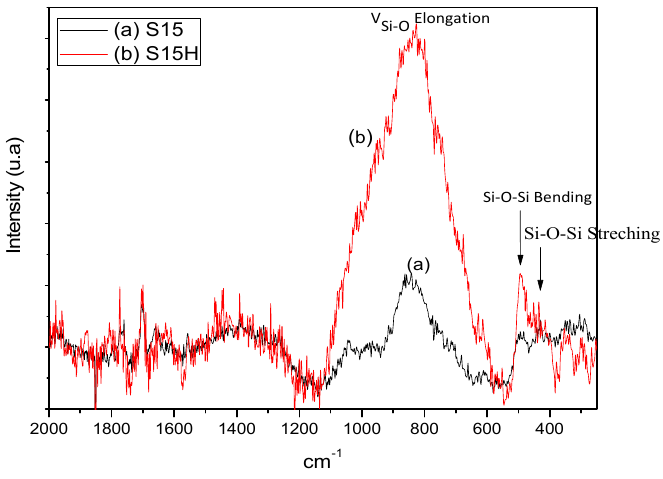
Figure 3. Raman spectra of SBA-15 materials: ( a ) precursor SBA-15 substrate (S15); and ( b ) silica after being treated with NaOH 0.025 M (S15H).